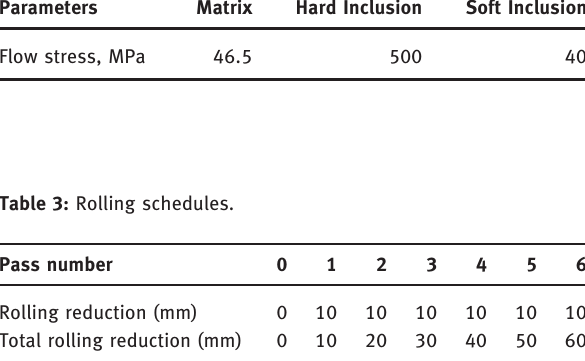
Figure 1: A finite element model is established using a new